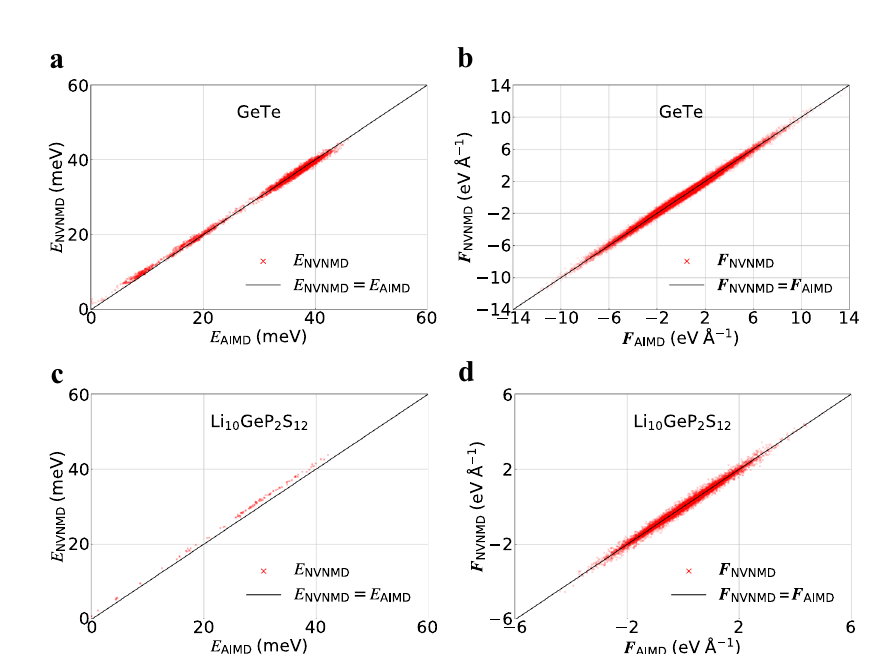
All molecular system calculations are based on the MD17 dataset 58 – 60 .